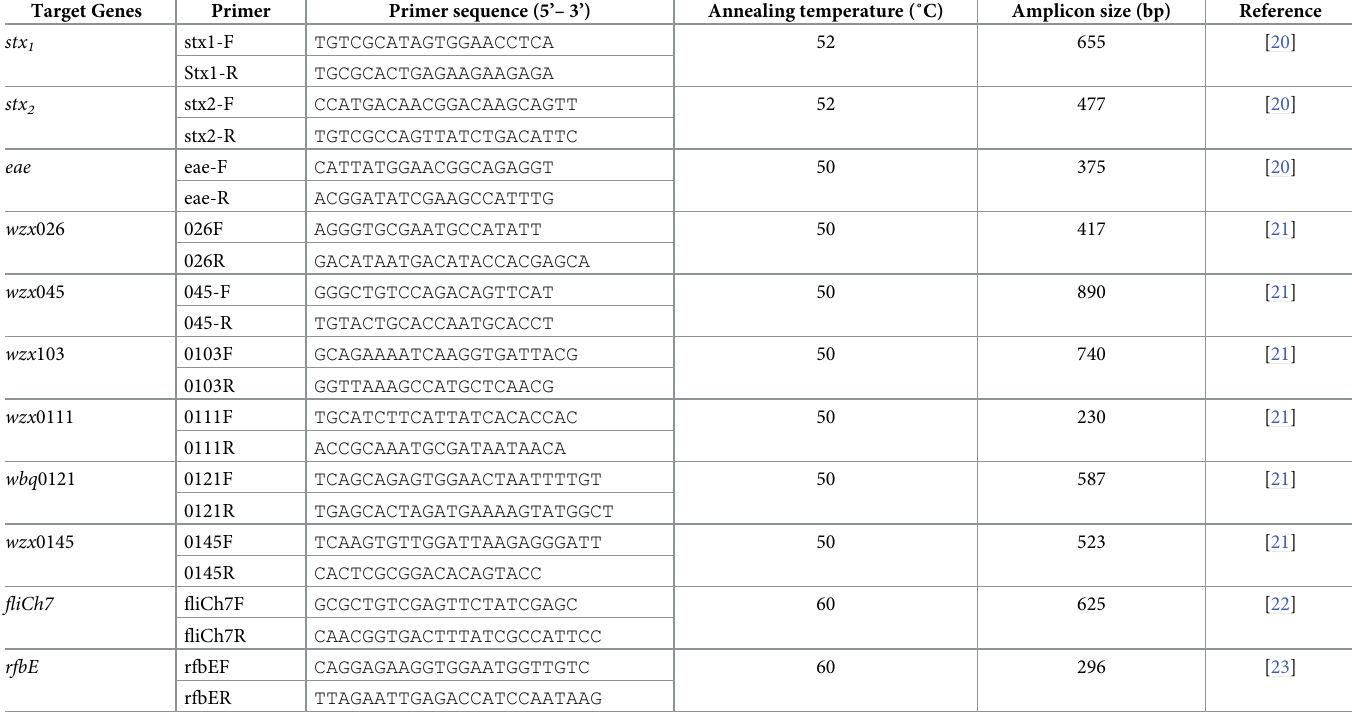
Table 2. List of primer sequences against which the samples have been tested. Target Genes Primer Primer sequence (5’–